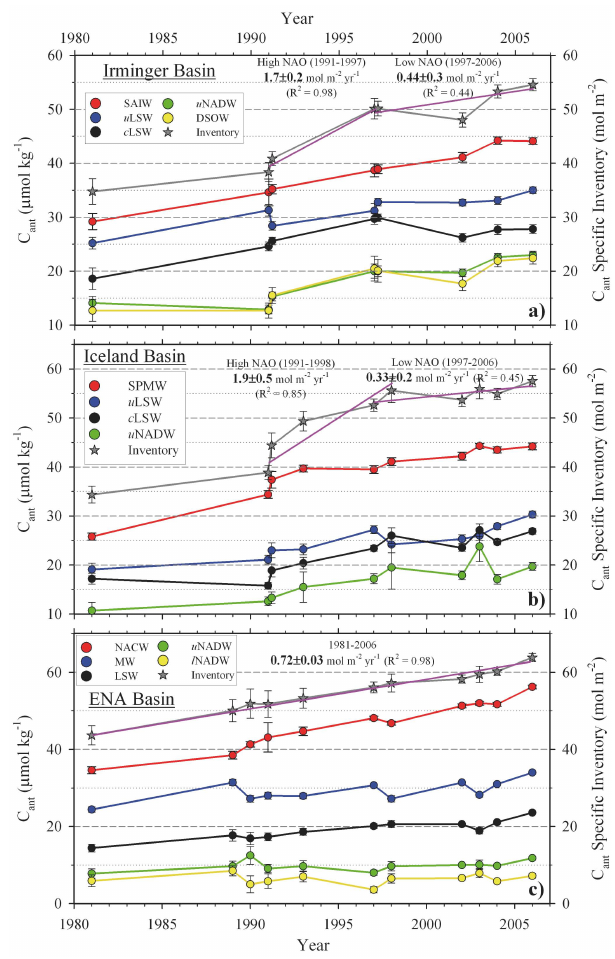
Fig. 3. Trends of average C ant concentrations in the studied water masses at the Irminger (3a), Iceland (3b) and ENA (3c; ∗ C ENA ,l,c ant plotted) basins. Notice that the y-axis scale is ad hoc for each graph. The grey lines give the specific inventories and the purple fit lines stand for the rates of change of the specific inventories (slope and R 2 given for the high and low NAO index periods, except for the ENA basin). The error bars represent the standard error of the